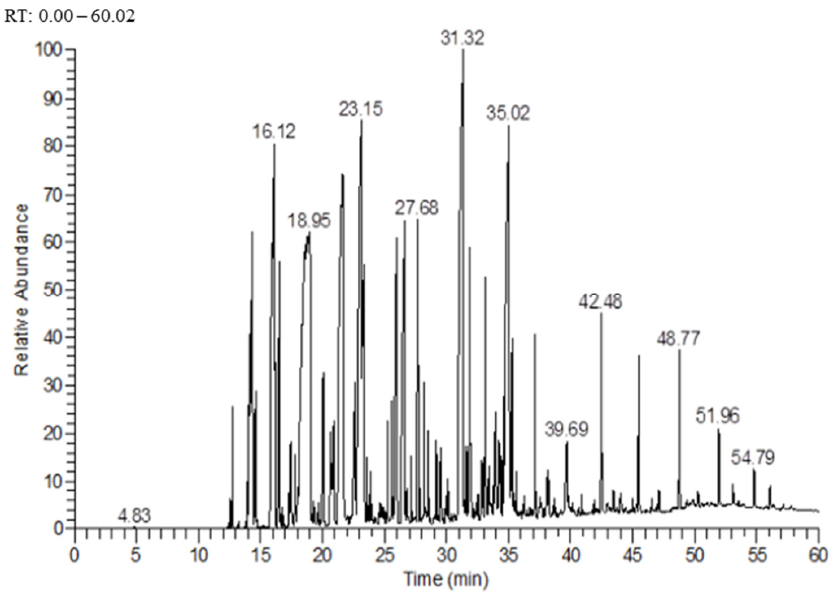
Figure 1. Chromatogram of the essential oil extracted from leaves of D. viscosa , presenting peaks with their retention times. Each peak represents the detector response for a different compound.